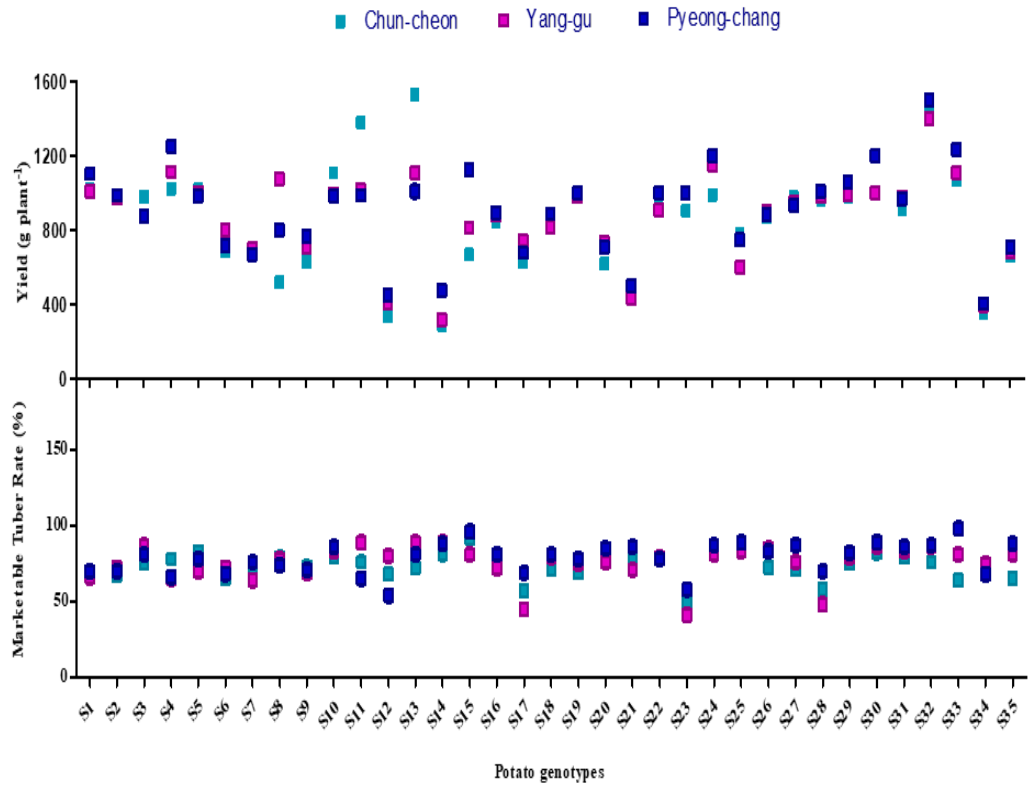
Figure 1. Average tuber yield (g / plant) and marketable tuber rate ( > 5 cm in diameter; %) of 35 potato lines grown in three agro-ecological regions: Chuncheon (low altitude), Yang-gu (middle altitude), and Pyeong-chang (alpine) in South Korea. The bars represent standard error mean (SEM). The di ff erences between tuber initiation and crop senescence, along with tuber bulking